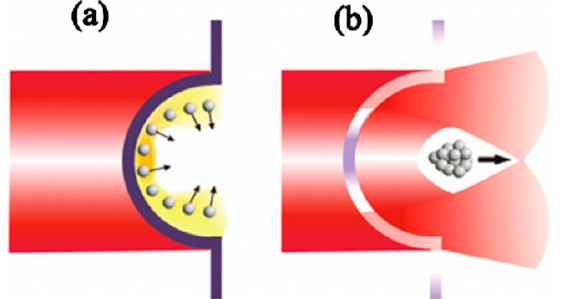
Figure 13. ( a ) Is conventional TNSA using a bulged target irradiated by a laser. Protons are grey balls and the electrons are the yellow cloud; ( b ) indicates a focused proton beam. Reproduced from [64]. Copyright 2010, AIP Publishing